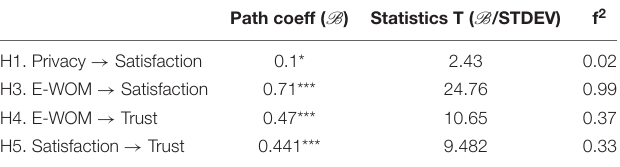
TABLE 5 | Comparison of